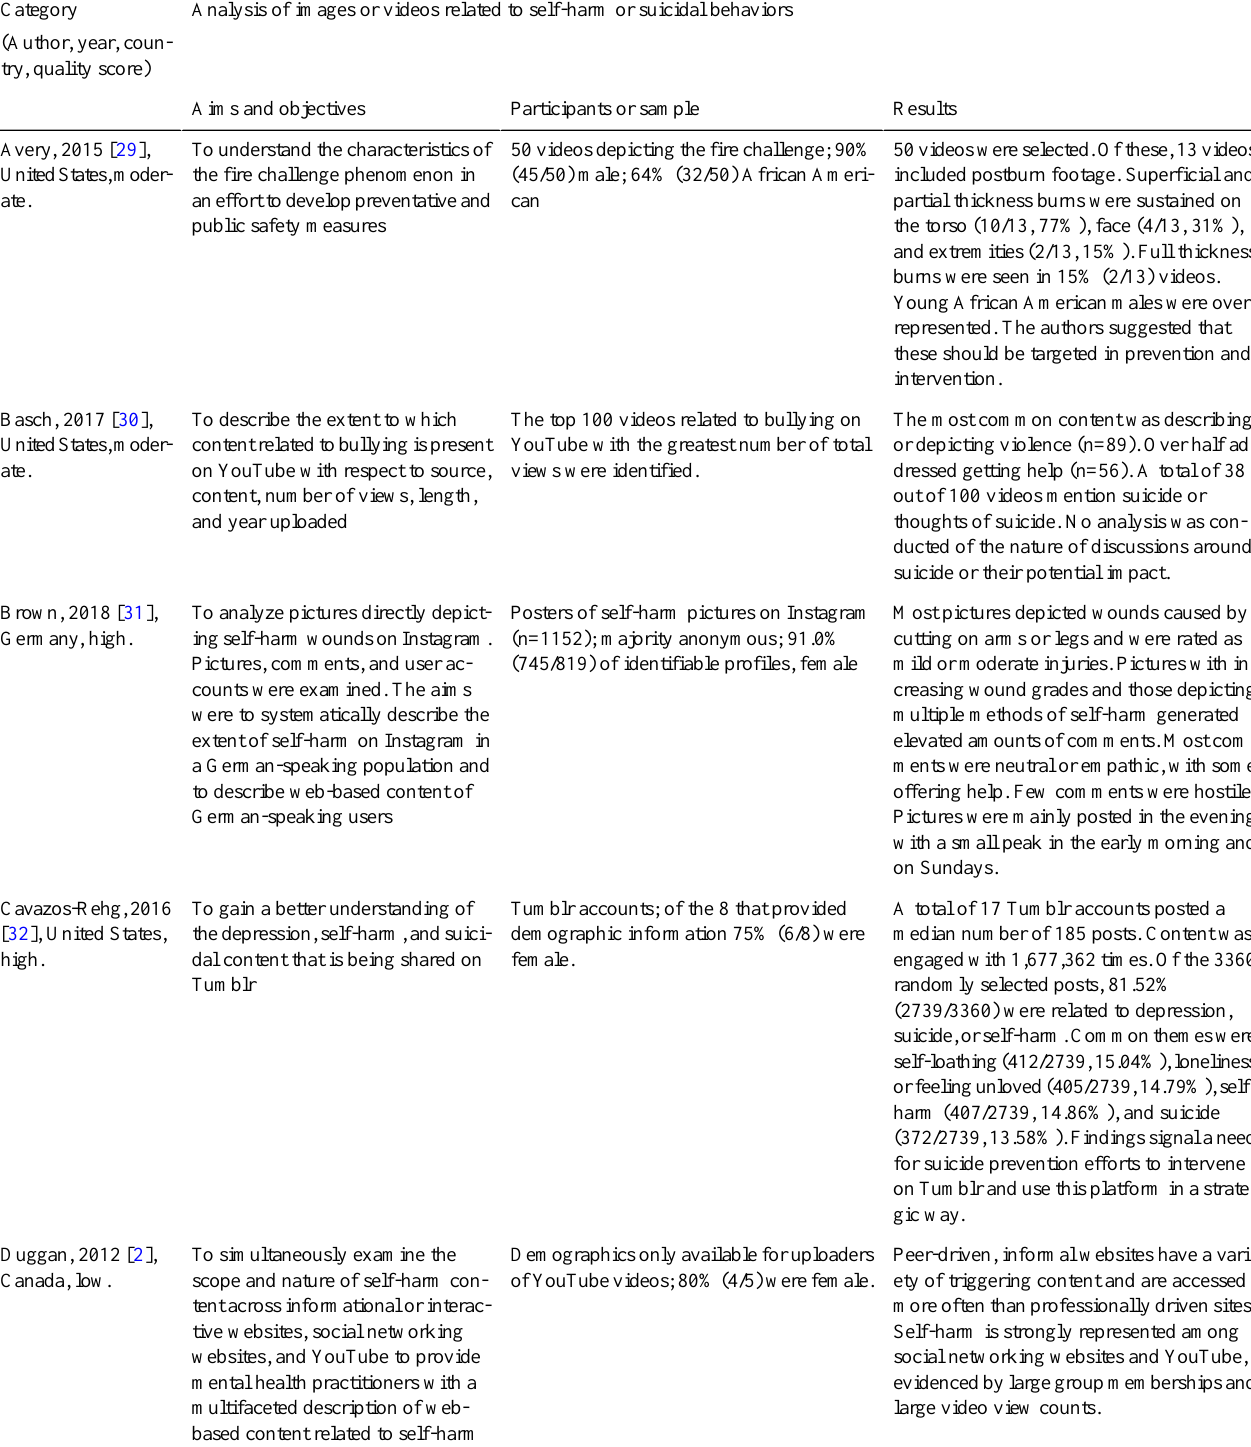
Table 1. Summary of included studies analyzing images or videos related to self-harm or suicidal behaviors. Analysis of images or videos related to self-harm or suicidal